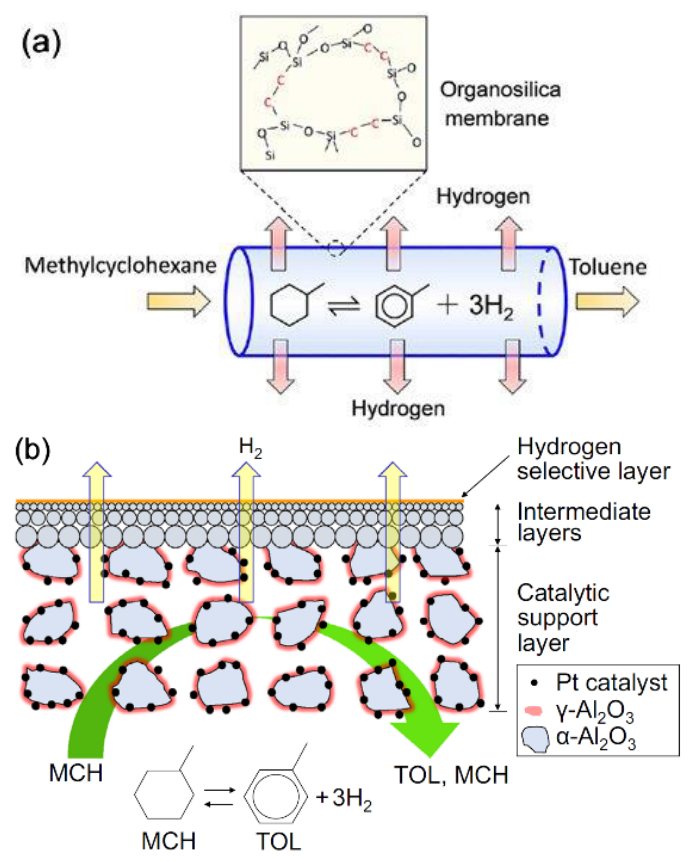
Figure 7. Schematic diagram of in-situ catalytic membrane reactor system. ( a ) multilayered catalytic tubular membrane reactor.; ( b ) Schematic structure of catalytic membrane . ( a , b ) adapted from [93] and [79], respectively, with permissions.